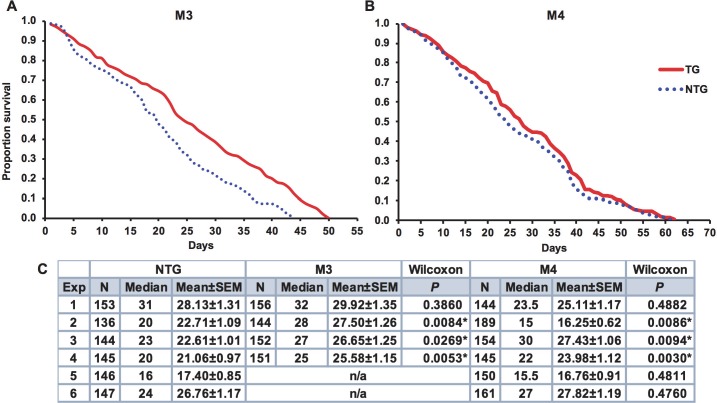
MKP4 overexpression in the midgut of A. stephensi increased median lifespan in M3 line transgenic relative to non-transgenic mosquitoes.Representative survivorship curves for M3 line MKP4 transgenic (A) and M4 line MKP4 transgenic (B)
A. stephensi relative to non-transgenic (NTG) controls. Lifespan experiments were replicated four (M3) or six (M4) times with separate cohorts of mosquitoes. (C) Summary of sample sizes, medians, means, and significance relative to NTG mosquitoes as determined by Gehan-Breslow-Wilcoxon analysis within individual experiments. Meta-analysis of the replicates revealed no difference in median lifespans between M4 line and NTG females, but median lifespan of the M3 line was significantly longer than that of NTG females (one-way ANOVA, P = 0.05).